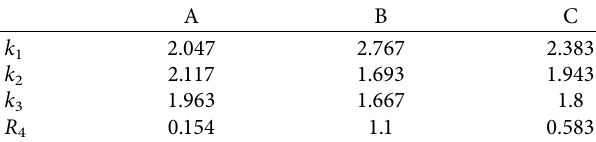
4 ) of paste filling.